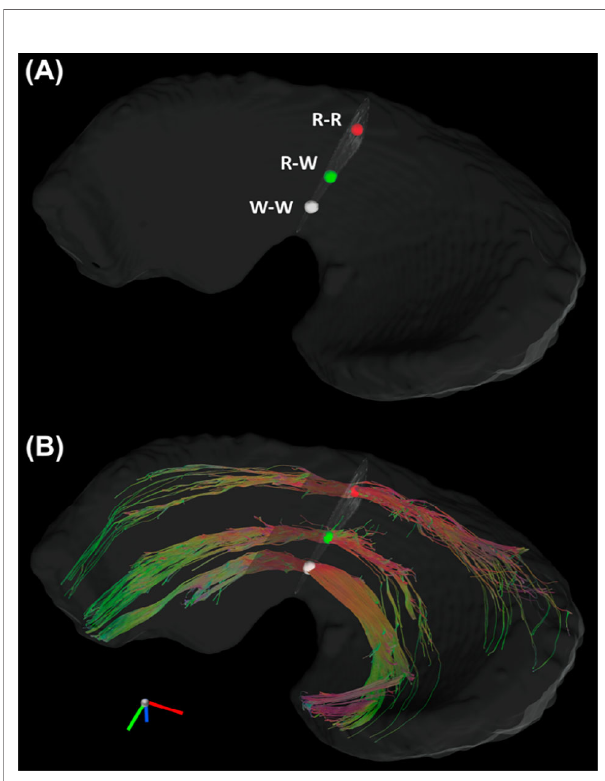
FIGURE 4 | The Tracts (B) from three seeding regions (A) : red area in R-R zone, white area in R-W zone, and white area from W-W zone. R-R, Red-Red zone; R-W, Red-White zone; W-W, White-White zone.